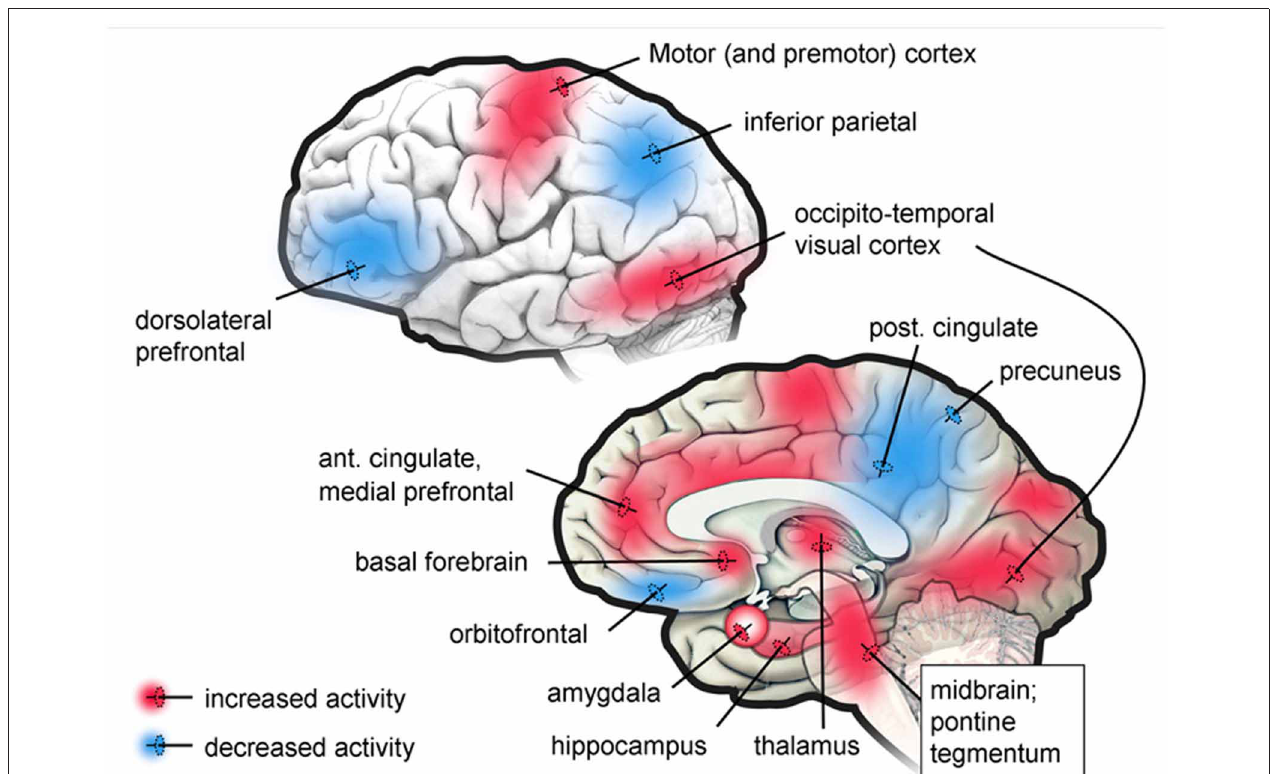
Table 1 | Neuromodulation varies across the wake-sleep cycle. Active wake Quiet wake SWS REM ACh Very high ++ High + Low − Very high + + + NE, 5-HT Very high ++ High + High + Low − When awake the concentration of acetycholine (Ach) and serotonin (5-HT) and norepinephrine (NE) vary from very high ( ++ ) to high ( + ). When in slow wave sleep the concentration of acetycholine decreases ( − ) while that of serotonin and norepinephrine remains high ( + ); but in REM sleep the concentration of acetycholine sharply increases ( + + + ) but that of serotonin and norepinephrine decreases ( −